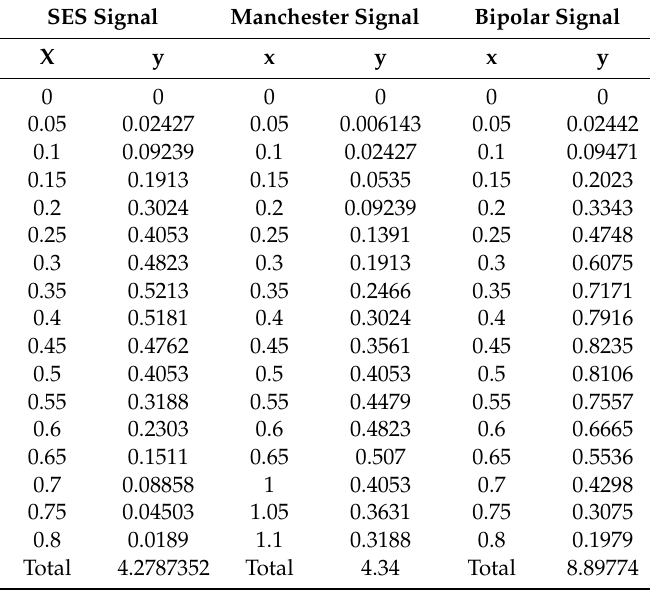
Table 5. SES vs. Manchester and Bipolar